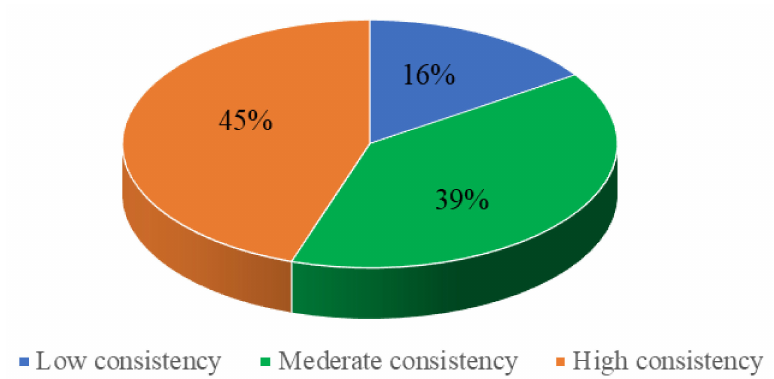
Figure 8. Consistency area percentage of all land cover types in the study area.